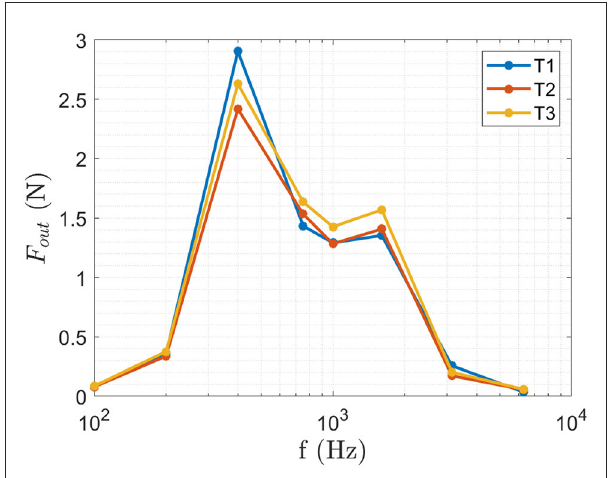
FIGURE2 The calibration curve for the transducers T1-T3 is used to calculate the perception threshold in Newton from the recorded Voltage applied to the transducers. The produced force F out was measured for f ∈ [100, 200, 400, 750, 1,500, 3,000, and 6,000] Hz at